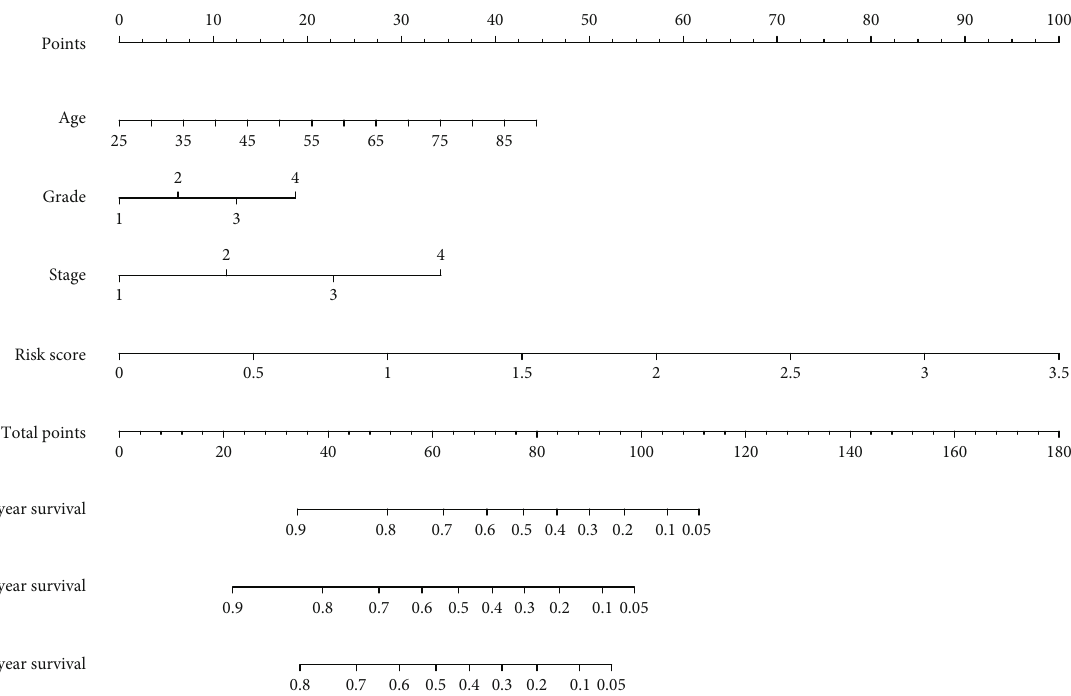
Figure 5: The novel nomogram was constructed based on the risk model for predicting 5-, 7-, or 10-year survival rates in KIRC. The value of each variable gets a score on the dot scale axis. The total score can be easily calculated by adding up each individual score and projecting the total score to a lower total score system, and we can estimate the risk of KIRC